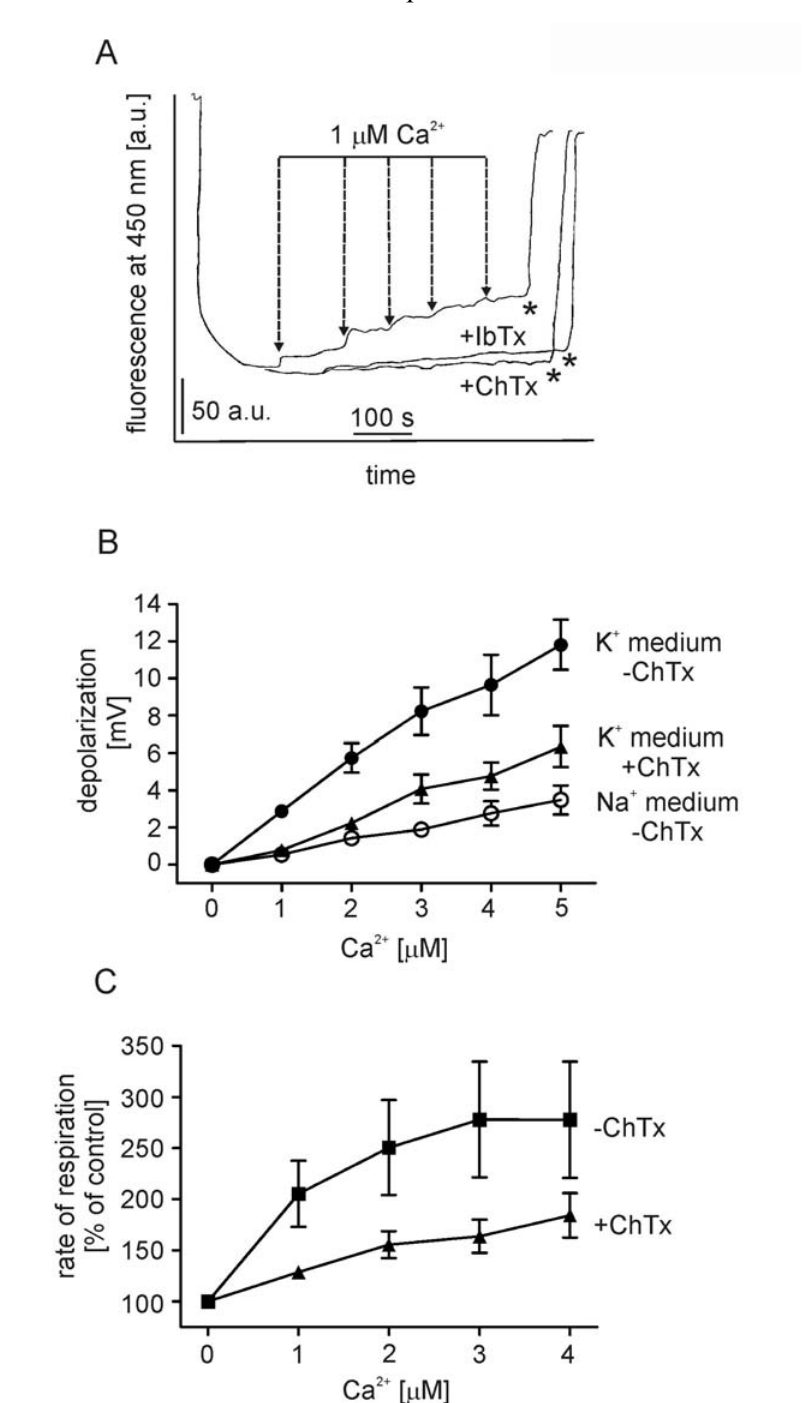
Figure 1. Effect of Ca 2+ on the membrane potential of isolated brain